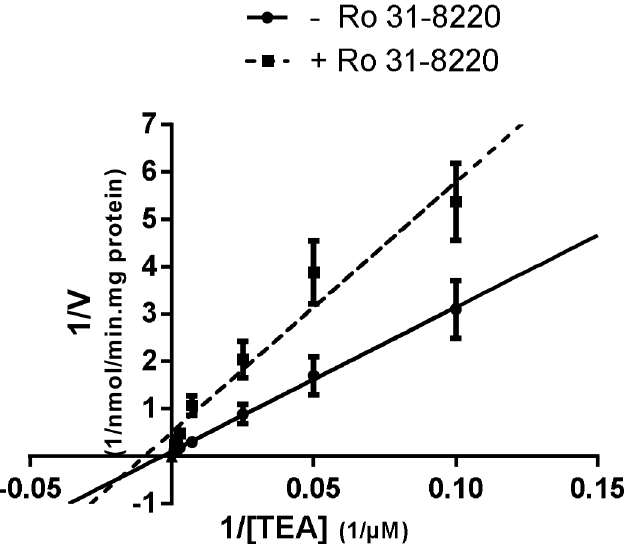
Fig 4. Lineweaver-Burk plot of the inhibitory effect of Ro 31 – 8220 on TEA uptake in HEK-OCT1 cells. HEK-OCT1 cells were incubated with various concentrations of TEA (from 10 to 1040 μ M) for 5 min at 37°C, in the absence or presence of 0.5 μ M Ro 31 – 8220. After washing with ice- cold PBS, intracellular accumulation of TEA was determined by scintillation counting and normalized to total protein content. Data shown are the means ± SEM of four independent